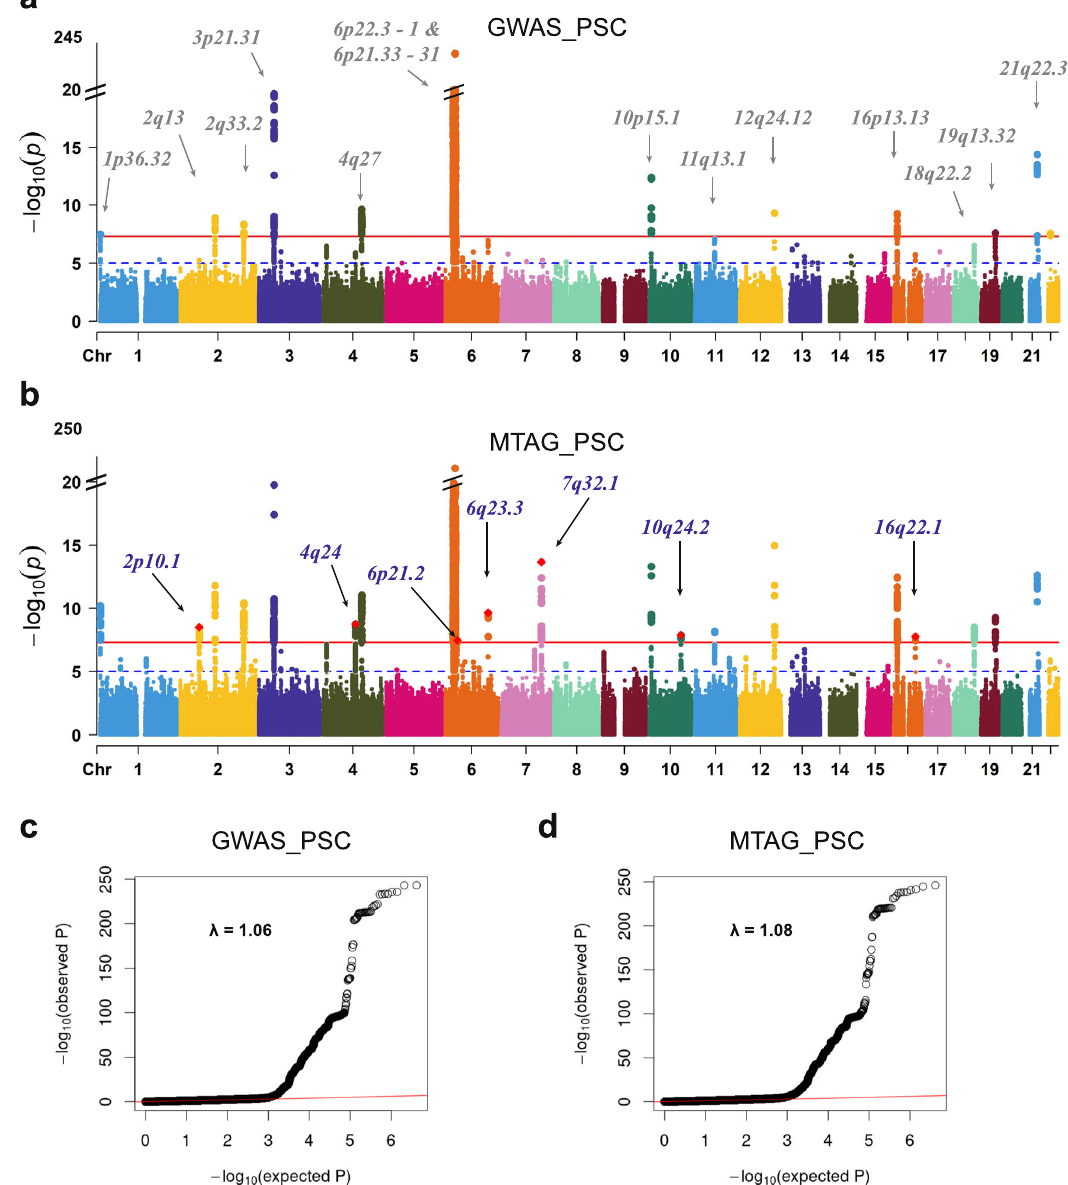
Fig. 3 | Manhattan plots and quantile-quantile plots for the single-trait GWAS and the multitrait GWAS of PSC. a , c PSC single-trait GWAS (Ji et al., 2017, PMID:27992413; GWAS_PSC). b , d MTAG-identi fi ed PSC-speci fi c GWAS against fi ve immune-mediated disorders, CD, UC, IBD, lupus, and PBC (MTAG_PSC). The x -axis represents chromosomal location, and the y -axis represents the − log 10 ( P -value). Thecytobandannotationsforthenewlyandpreviouslyidenti fi edlociareinpurple